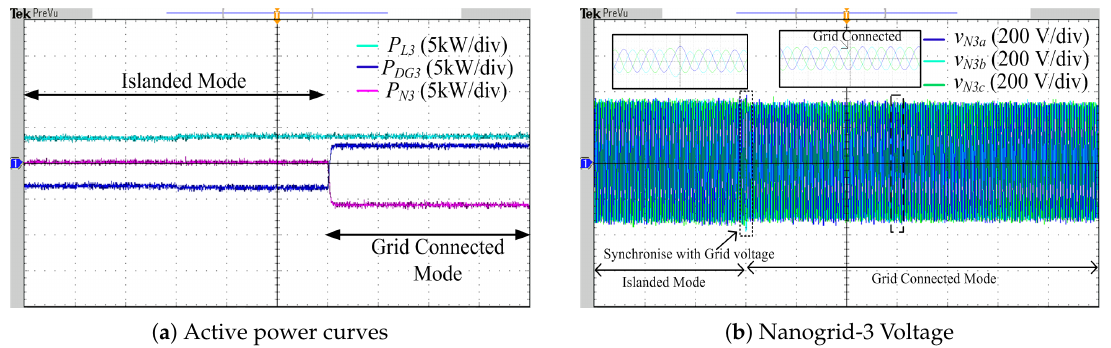
Figure 10. Transition of nanogrid-3 during islanded to grid connected operating mode.